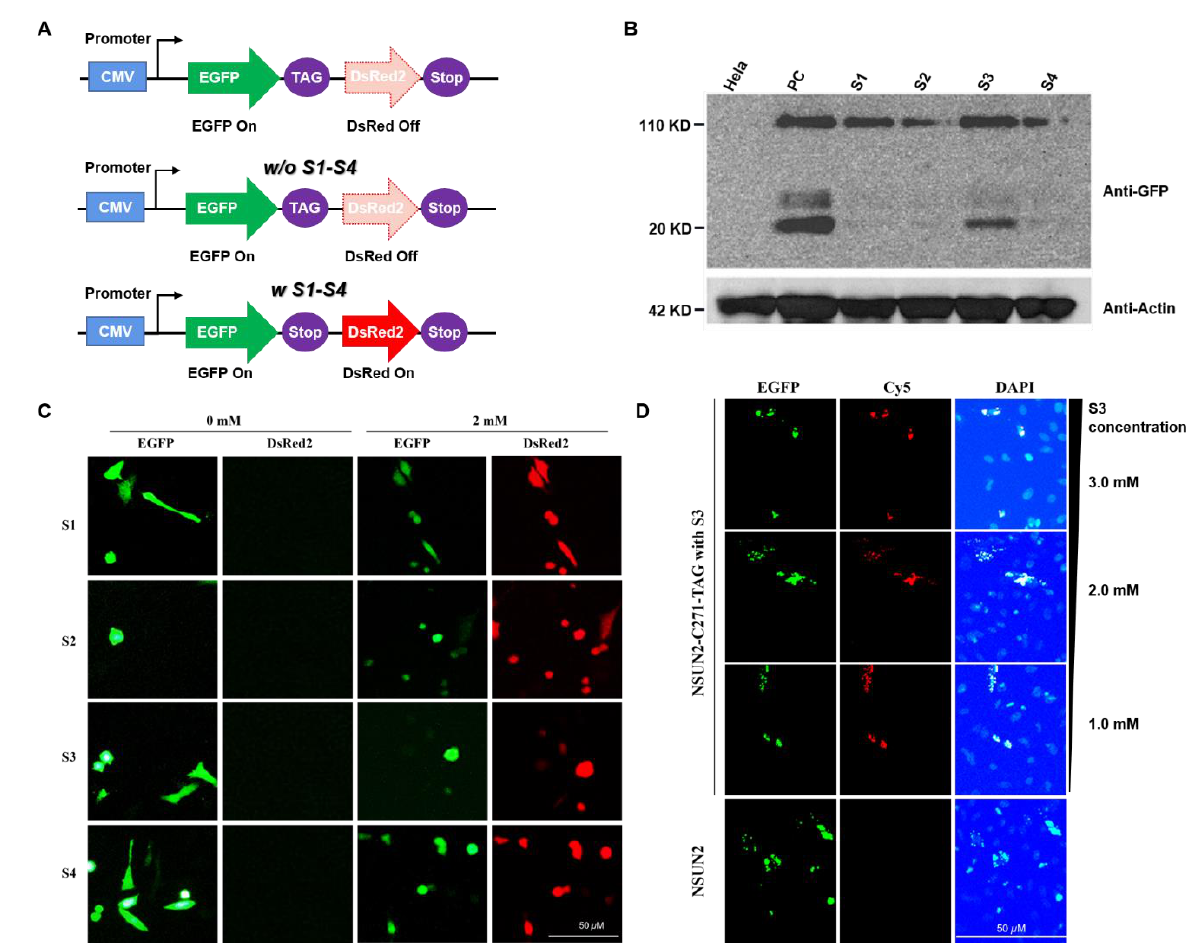
Figure 3. Fluorescent labeling of NSUN2 . ( A ) Schematic presentation of the construction of the dual fluorescent reporter system. ( B ) Detection of replacement efficiencies using various unnatural amino acids by monitoring expressions of the NSUN2 protein through Western blot assays. HeLa cells expressing the MbPylRS -tRNA CUA system were cultured in DMEM medium containing S1–S4 (2.0 mM). Briefly, HeLa cells were lysed and total proteins extracted after 24 h. Protein expression levels were detected by Western blot. HeLa cells transfected with the NSUN2 overexpression plasmid were set as the positive control group. S1–S4 exhibited great replacement efficiencies (110 KD band). ( C ) Detection ofthe recognizing of the screened MbPylRS-tRNA CUA to the specific amino acid derivatives. In the absence of S1–S4 (0 mM, left), only green fluorescent protein signals were detected. In the presence of S1–S4 (2.0 mM), both EGFP and DsRed protein signals were recorded (right). ( D ) HeLa cells expressing the MbPylRS -tRNA CUA amino acid substitution and GFP-NSUN2 C271TAG mutation systems were cultured in DMEM medium supplemented with different concentrations of S3 (1.0, 2.0, and 3.0 mM) and incubated for 24 h. Then, DBCO-Cy5 (50 µM) was added to react with lys-N 3 (S3) in NSUN2 . Subcellular localization of NSUN2 was identified by dual-color fluorescence imaging when S3 (as low as 1.0 mM) was applied. Scale bar: 50 µM.